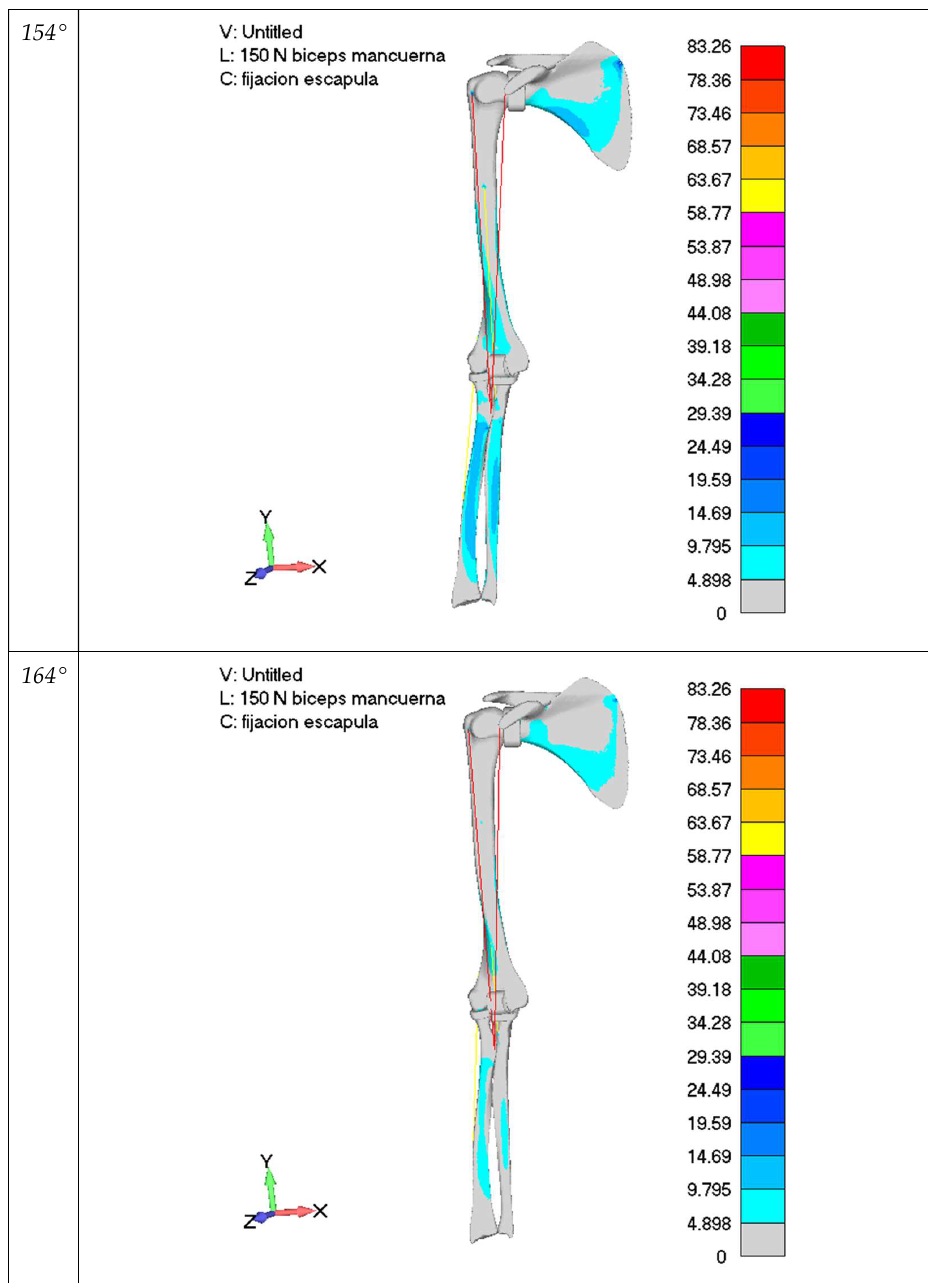
Figure A1. Different Elbow Angle Configuration: Bone Von Mises Stress Distribution Biceps Load- ing Case (150 N on wrist).